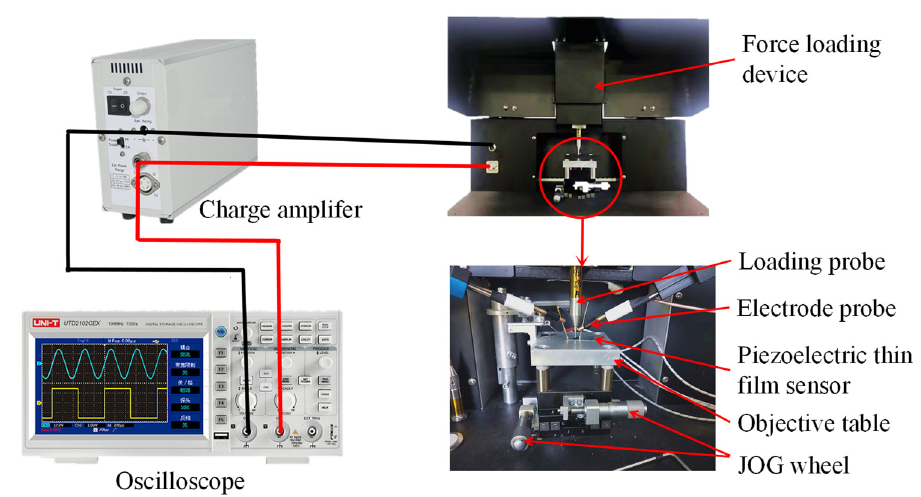
Figure 7. The dynamic testing system of the piezoelectric film sensor.